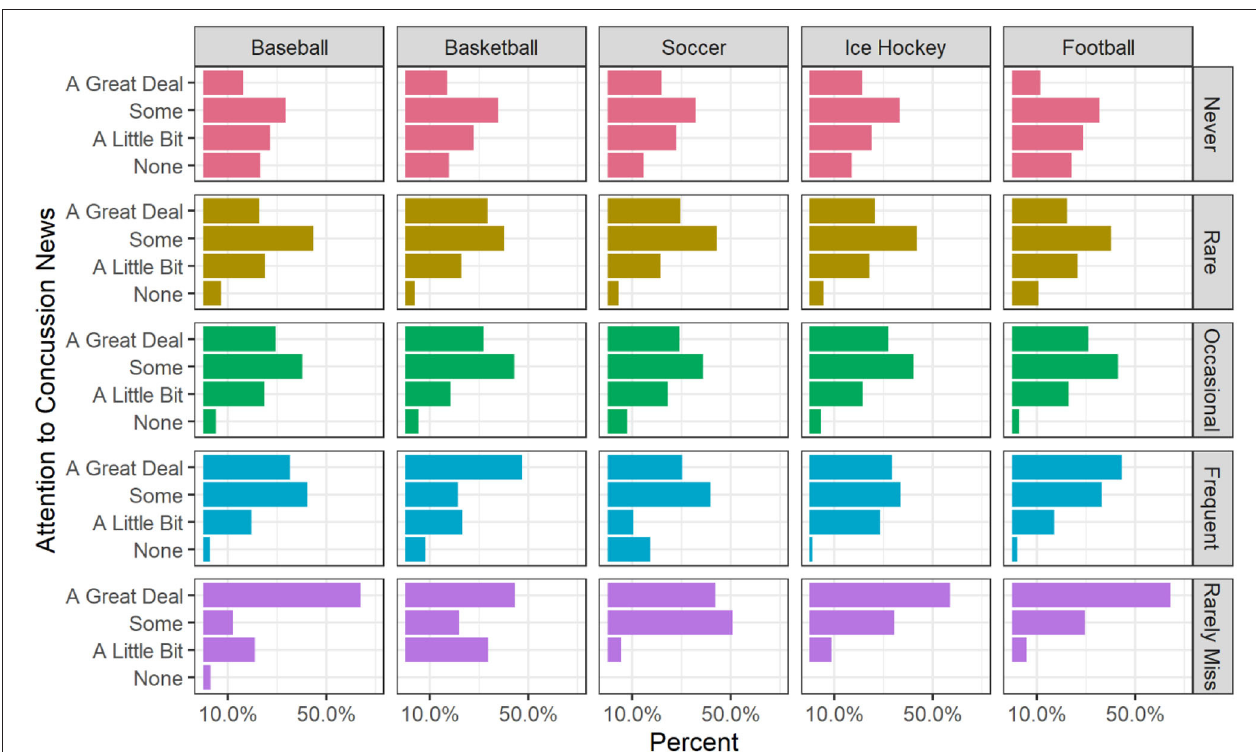
FIGURE 3 | Attention to concussion news by frequency of watching sports (Weighted). higher levels of attention to news of concussions in